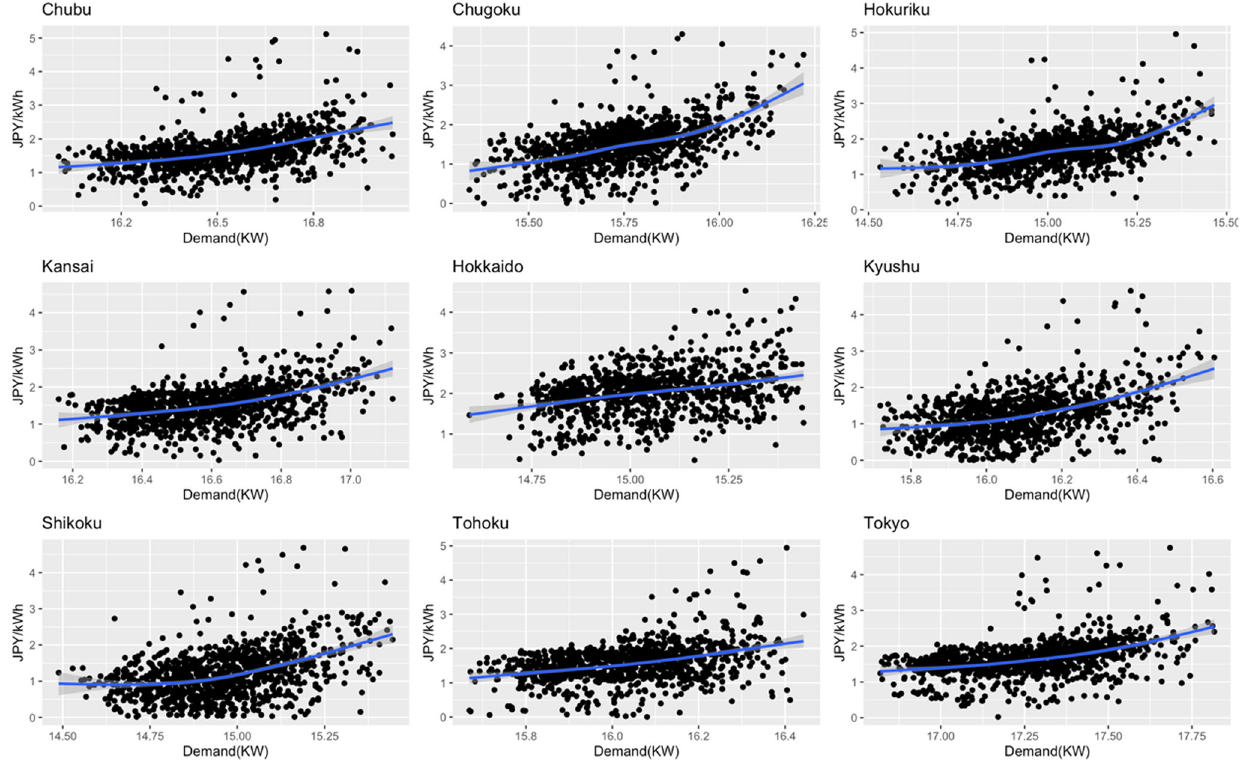
Fig. 3 Relationship between hourly electricity spot market price and hourly electricity demand in Chubu, Chugoku, Hokuriku, Kansai, Hokkaido, Kyushu, Shikoku, Tohoku, and Tokyo. The scatterplot and smooth line capture the non-linear relationships between electricity price and demand in nine regions.